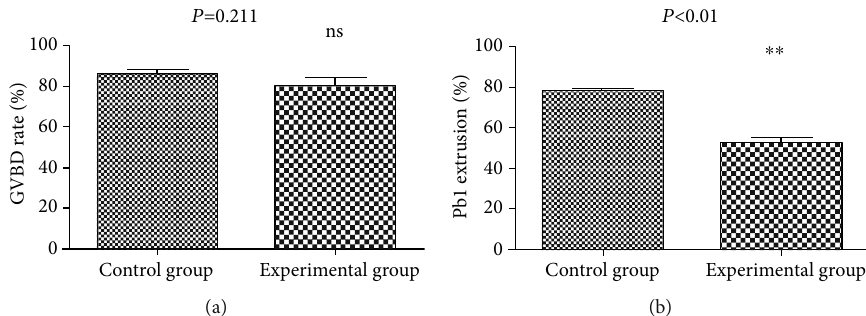
Figure 4: E ff ects of the CENP-C antibody on oocyte maturation. Oocytes during germinal vesicle breakdown were detected after 3 hours of culture from GV oocytes. Oocytes during fi rst polar body (Pb1) extrusion were observed after 14 hours of in vitro maturation of GV oocytes. (a) Quantitative analysis of GVBD in the control group and experimental group ( 80 : 23 ± 3 : 71 % vs. 86 : 27 ± 1 : 62 % control, P = 0 : 211 ). (b) Quantitative analysis of Pb1 extrusion in the control group and experimental group ( 52 : 73 ± 2 : 03 % vs. 77 : 90 ± 1 : 06 % control, P < 0 : 01 ). Data were expressed as mean ± SEM from 3 independent experiments. ∗∗ P < 0 : 01 Table 1: Comparison of GVBD between the experimental group and the control group. Experimental group GVBD